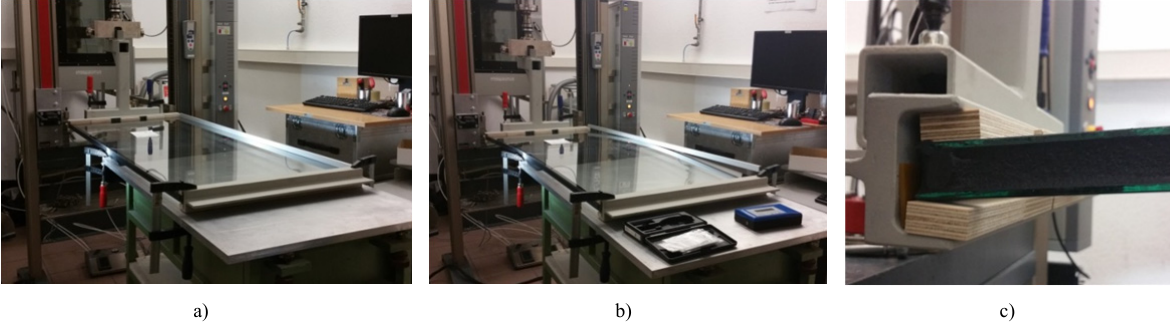
Fig. 22 Test Assambly for the 1-axial bending tests with 1 500 mm x 600 mm IGUs; a) no laod applied; b) Δ l = 50 mm c) clamping of one edge @ Δ l = 50